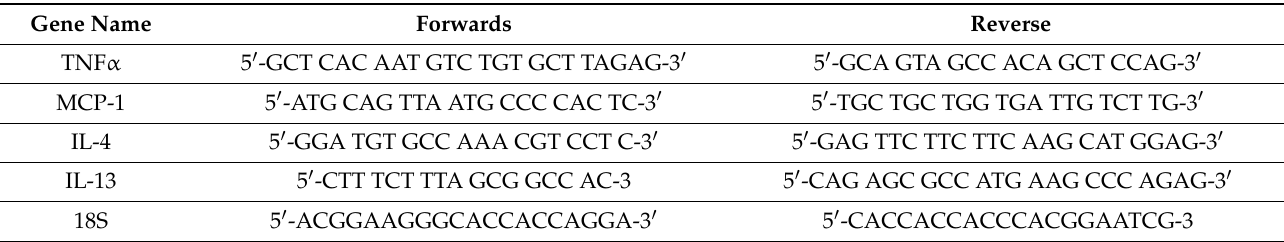
Table 1. Primers of various